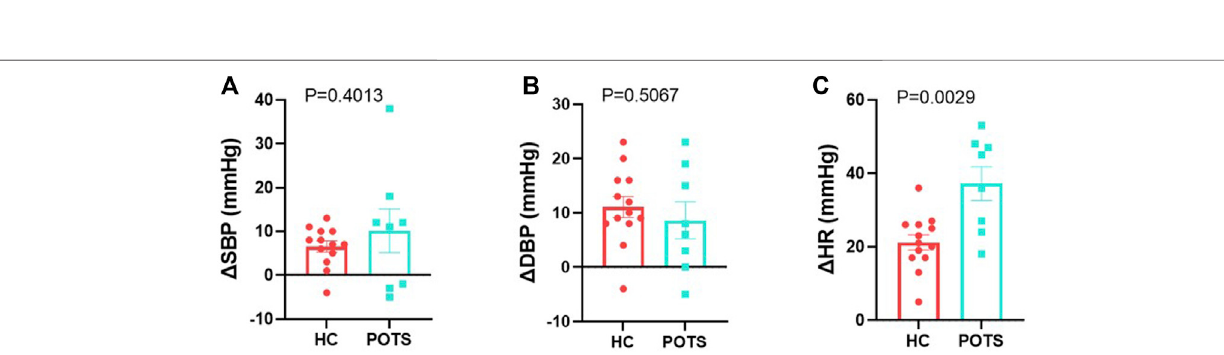
Frontiers in Physiology |